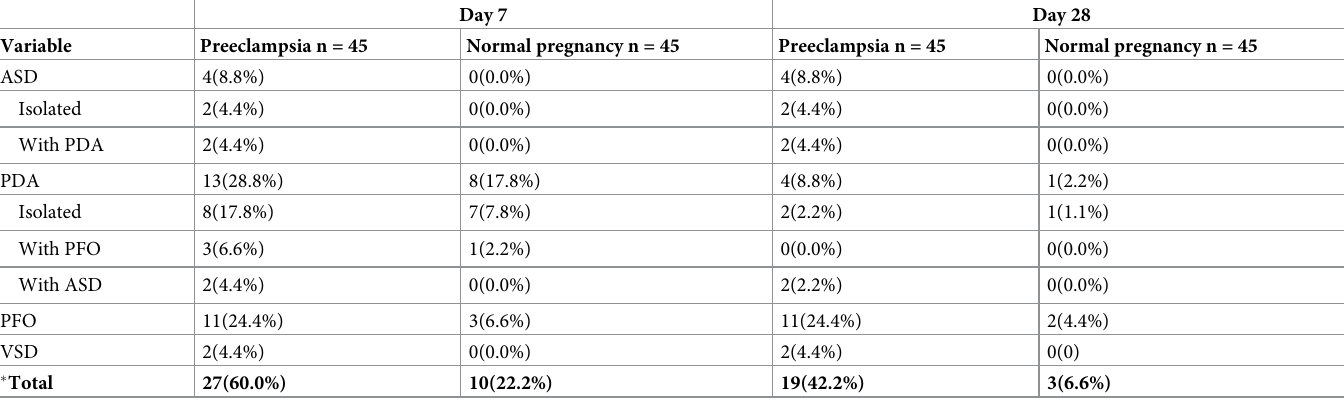
Table 2. Frequency of occurrence of type of congenital heart disease (CHD) in the study population (N = 90) by exposure status.